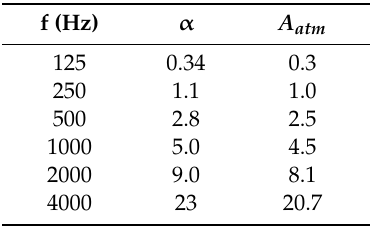
Table 6. Atmospheric attenuation values.